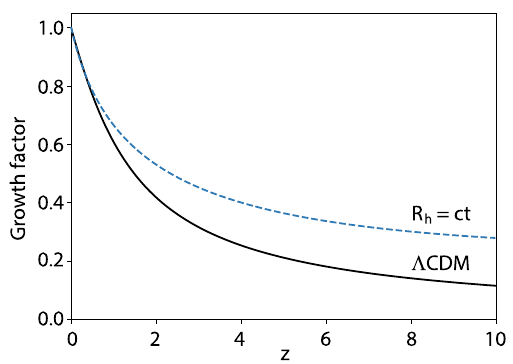
Fig. 1 Growth Factor predicted by R h = ct (dashed) and flat Λ CDM (solid)